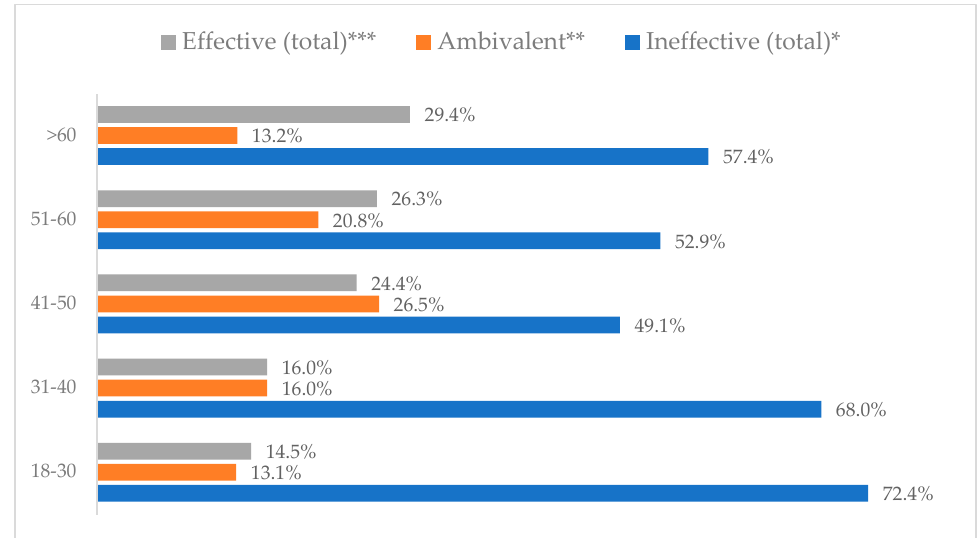
Figure 31. Taking vitamin C daily to prevent influenza virus infection by gender ( N = 905). *Sum of responses: completely ineffective, ineffective, rather ineffective; ** Response: neither ineffective nor effective; *** Sum of responses: rather effective, effective, completely effective.